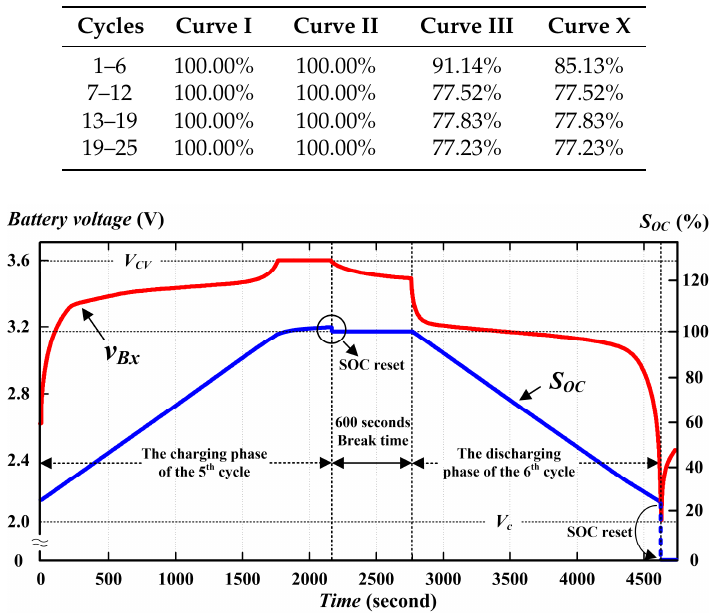
Table 3. The SOHs of four tested cases throughout the experiment.